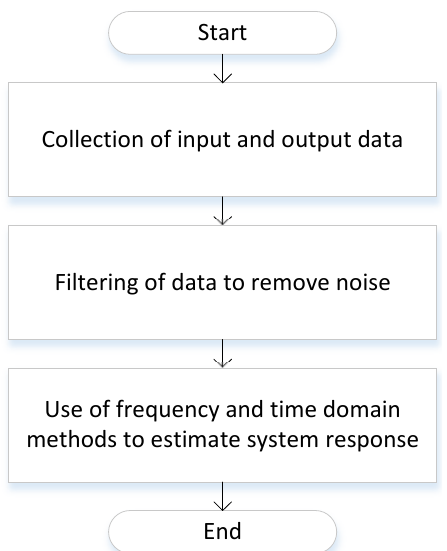
Figure 7. Non-parametric